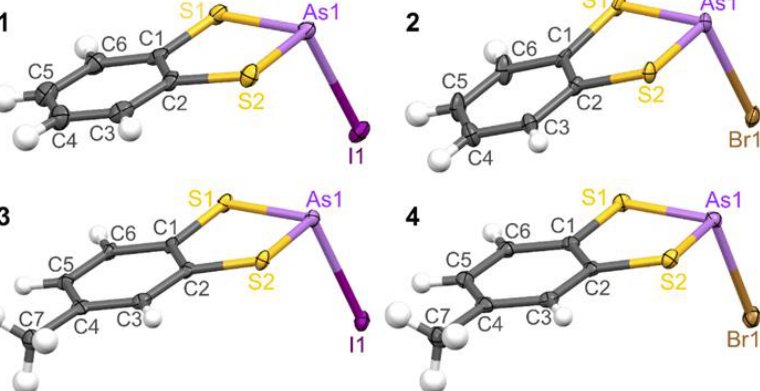
Figure 2. Molecular structure of compounds 1 – 4 .